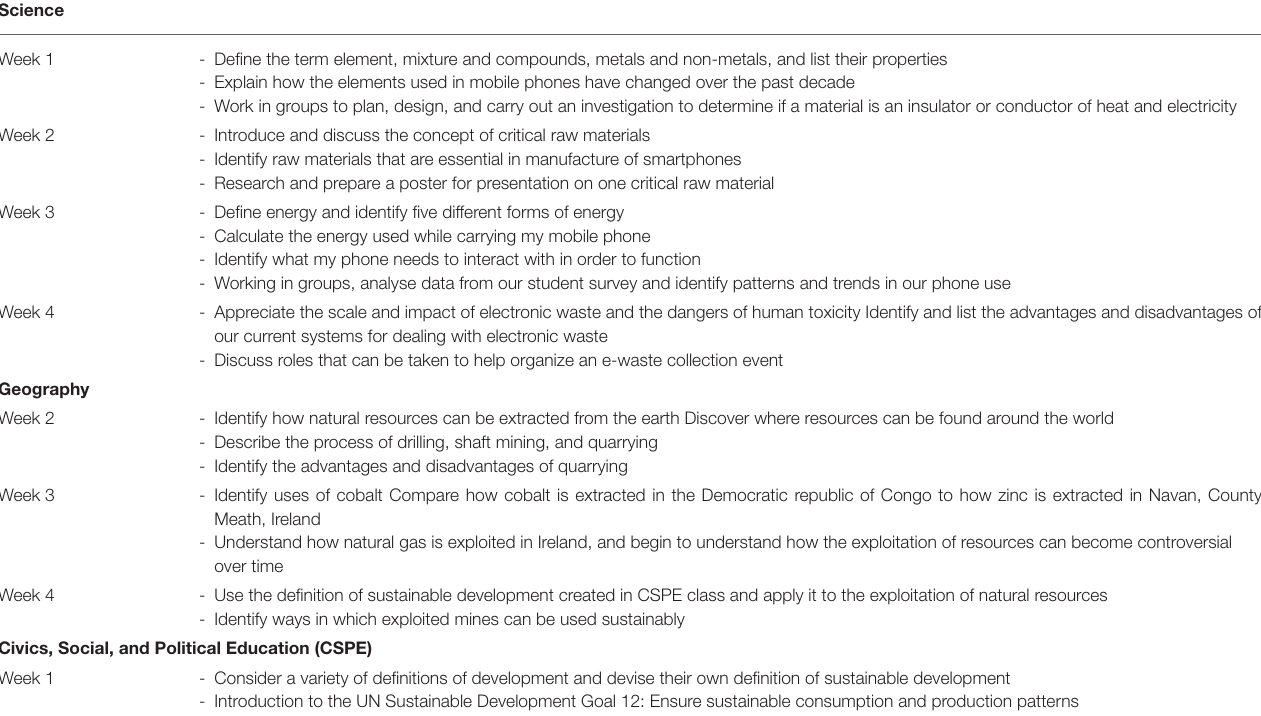
TABLE 2 | Overview of learning outcomes for subjects over the course of the E-Mining@School project. Science Week